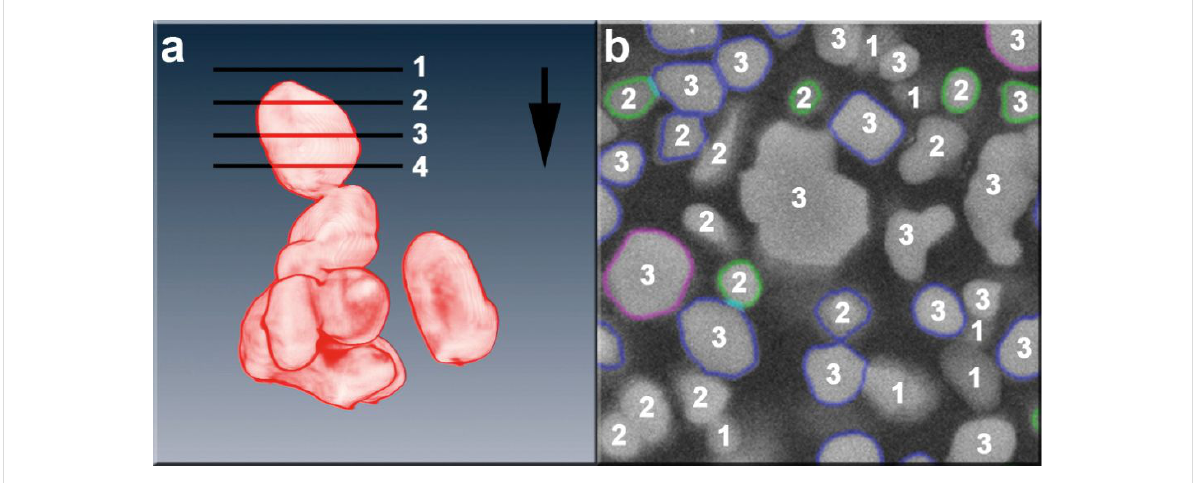
Figure 3: Visualisation of the systematic challenges in the detection of sectioned particles; a) principal possibilities for sectioning a particle; the viewing direction is indicated by the black arrow; lines 1 to 4 indicate section planes through the particle shown; b) a representative electron micro- graph of a polished section; the numbers given correspond to the sections given exemplarily in part (a); the particles with a coloured envelope are the ones finally detected after grey-value and morphologic filtering.